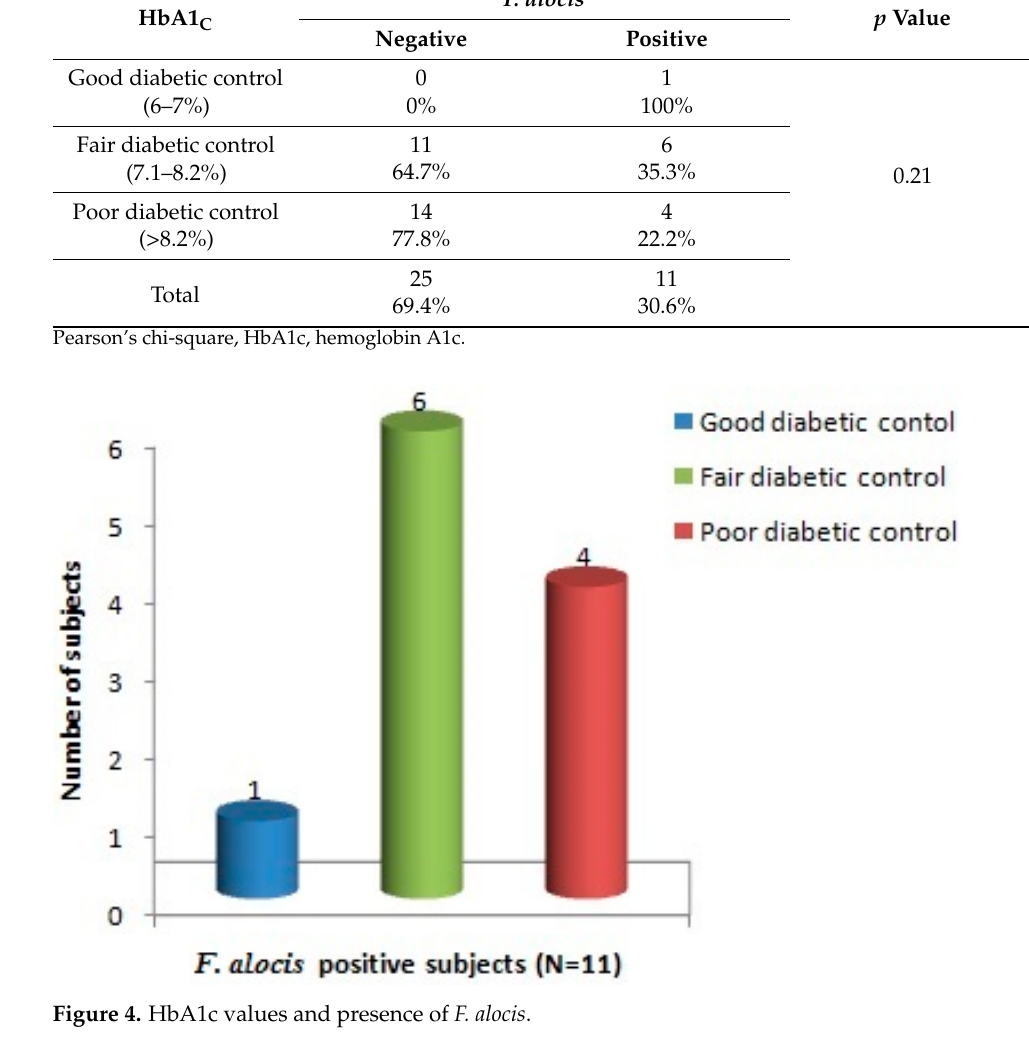
Figure 4. HbA1c values and presence of F. alocis